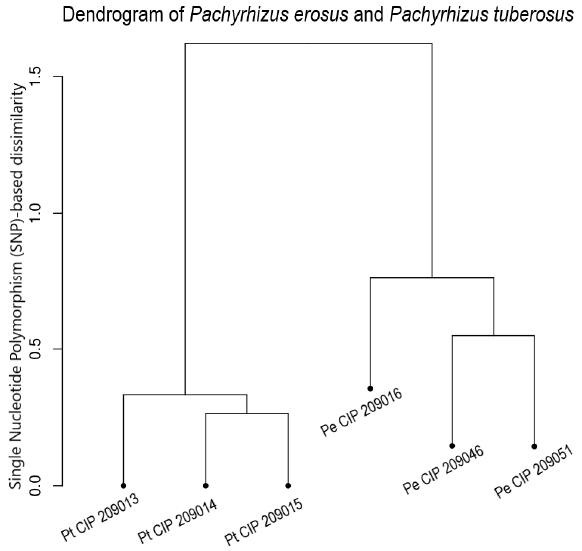
Figure 2. A single nucleotide polymorphism (SNP) phylogenetic cluster tree of six yam bean culti- vars. Pt: Pachyrhizus tuberosus , Pe: Pachyrhizus erosus. The Pachyrhizus tuberosus cultivars were all sourced from Peru, while Pe-CIP-209016, Pe-CIP-209046 and Pe-CIP-209051 were sourced from Guatemala, Cartago Costa Rica, and Mexico,